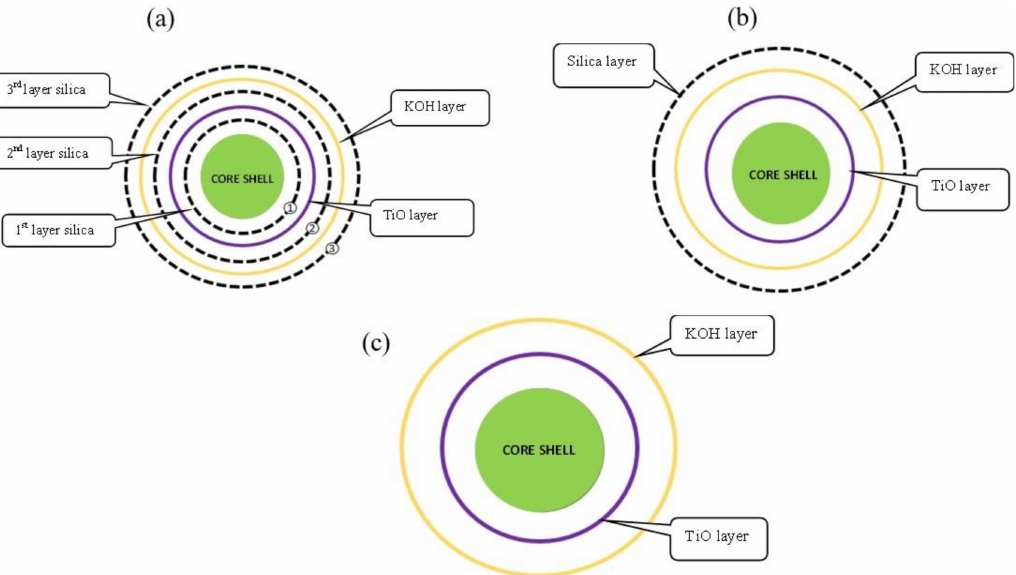
Figure 2. Core shell structures. ( a ) Core shell with multiple silica layers. ( b ) Core shell with single layer silica. ( c ) Core shell without silica